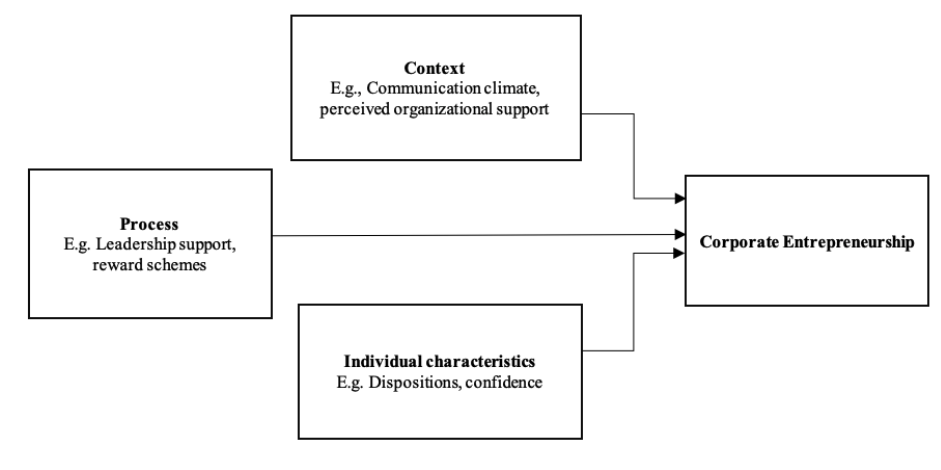
Figure 1: The three antecedents of corporate entrepreneurship; Source: